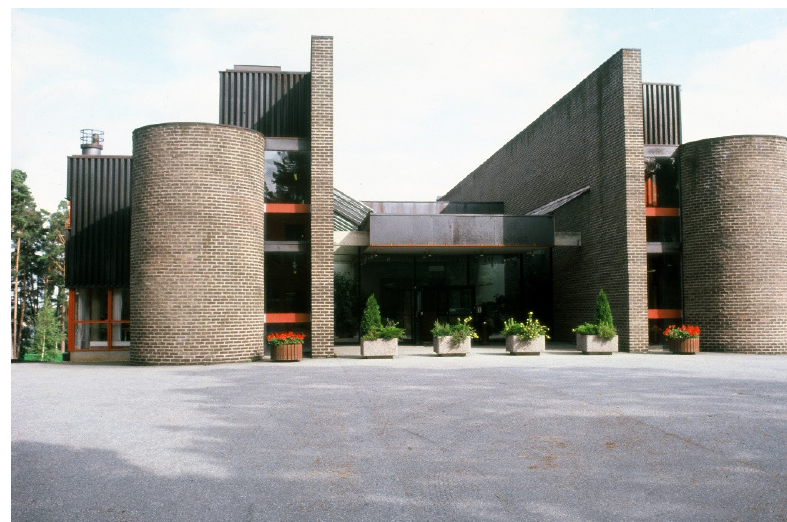
Figure 5. Entrance façade of IBM with staircase towers and a basilica structure with higher auditoriums flanked by two-storey aisles. Photo by Claes Caldenby.